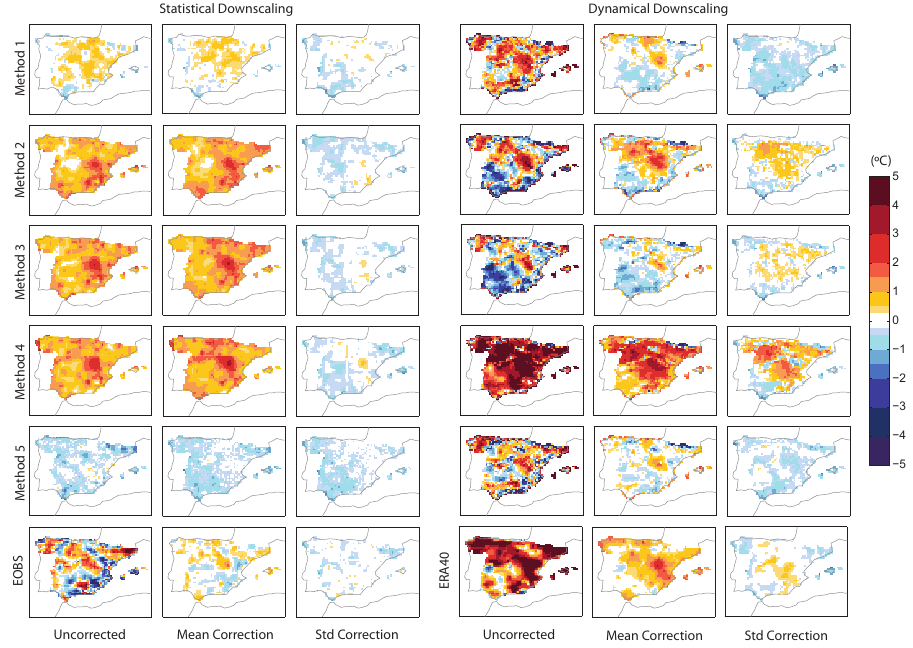
Fig. 3. Spatial bias distribution (in ◦ C) for the 5th percentile of daily minimum temperature for statistical (left panel) and dynamical (right panel) methods with respect to Spain02 in winter. The first column of each panel represent the bias without doing any correction. The second column represents the bias when the correction in the seasonal mean is done. The third column represents the bias when the second-order correction is done. E-OBS and ERA-40 biases with respect Spain02 are also included in the last row.